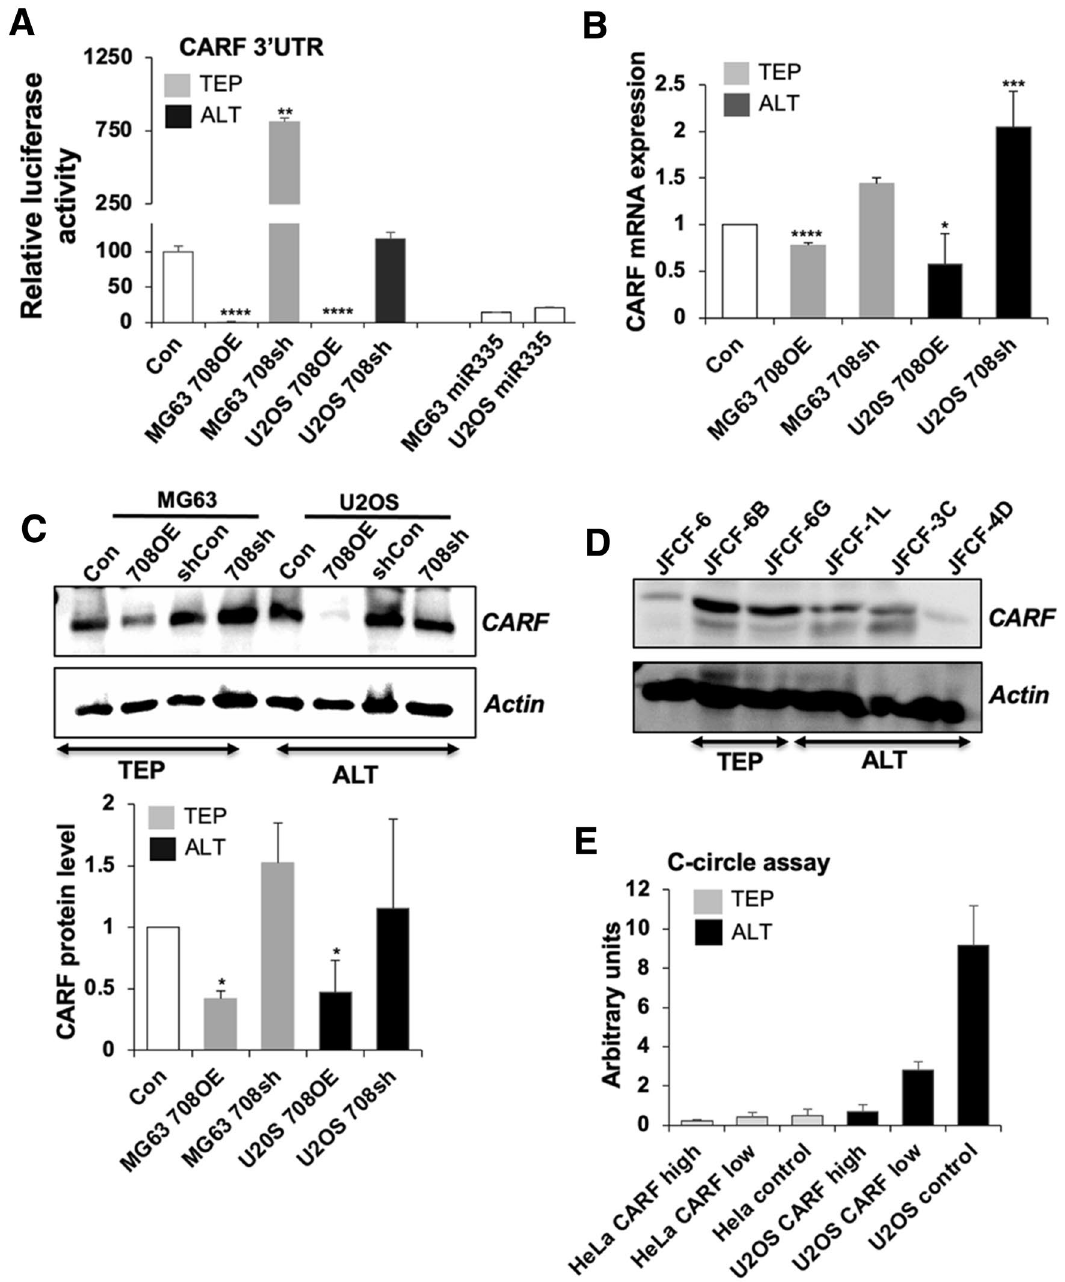
Figure 4. CARF is a target of miR-708 and is associated with C-circles. ( A ) Luciferase assay showing repression of CARF 3 ′ UTR enhancer activity by miR-708 in miR-708-overexpressing and -deficient TEP and ALT cell lines. The relevant controls (Con) were assigned a value of 100. miR-355 overexpressing TEP and ALT cells were used as positive controls. ( B ) RT-qPCR for CARF shows that its transcript level was decreased in both miR-708-overexpressing MG63 and U2OS cells whereas it is increased in the miR-708-depleted cells. The relevant controls (Con) were assigned a value of 1. ( C ) Overexpression of miR-708 reduced CARF protein levels. Quantitation is shown in the lower panel as mean ± SD, n = 4. ( D ) In a panel of TEP (JFCF-6/T.1J/6B, JFCF- 6/T.1J/6G) and ALT (JFCF-6/T.1J/1L, JFCF-6/T.1J/3C and JFCF-6/T.1J/4D) cell lines derived from the same parental cell line JFCF-6), the CARF protein level was lower in ALT cells than in TEP cells. ( E ) The amounts of C-circles in ALT cells-stably expressing extremely high (high) and moderately high (low) level of CARF as compared to the control (vector-infected cells). * p < 0.05; ** p < 0.01; *** p < 0.001; **** p <